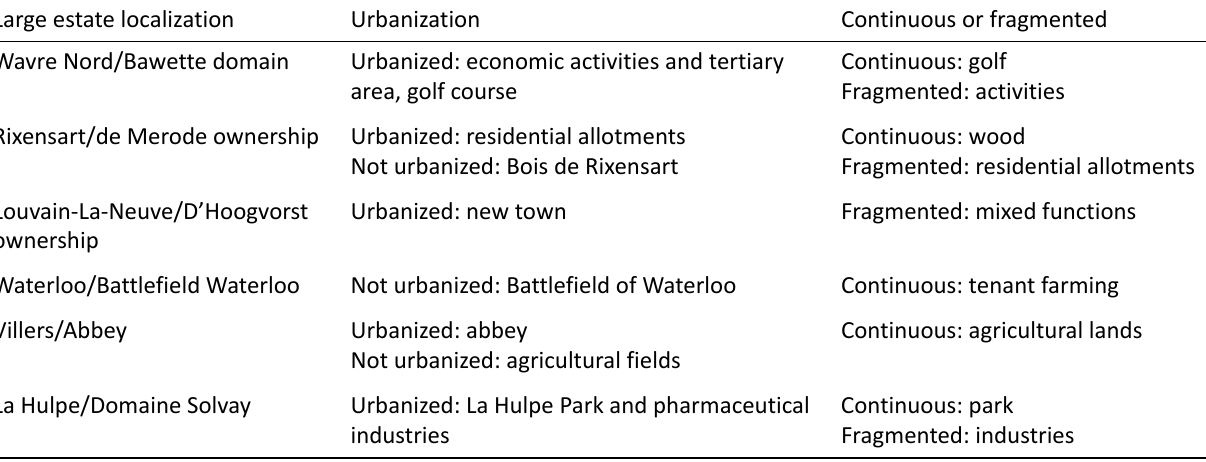
Table 1. Selection of former noble large land holdings in Walloon Brabant and their